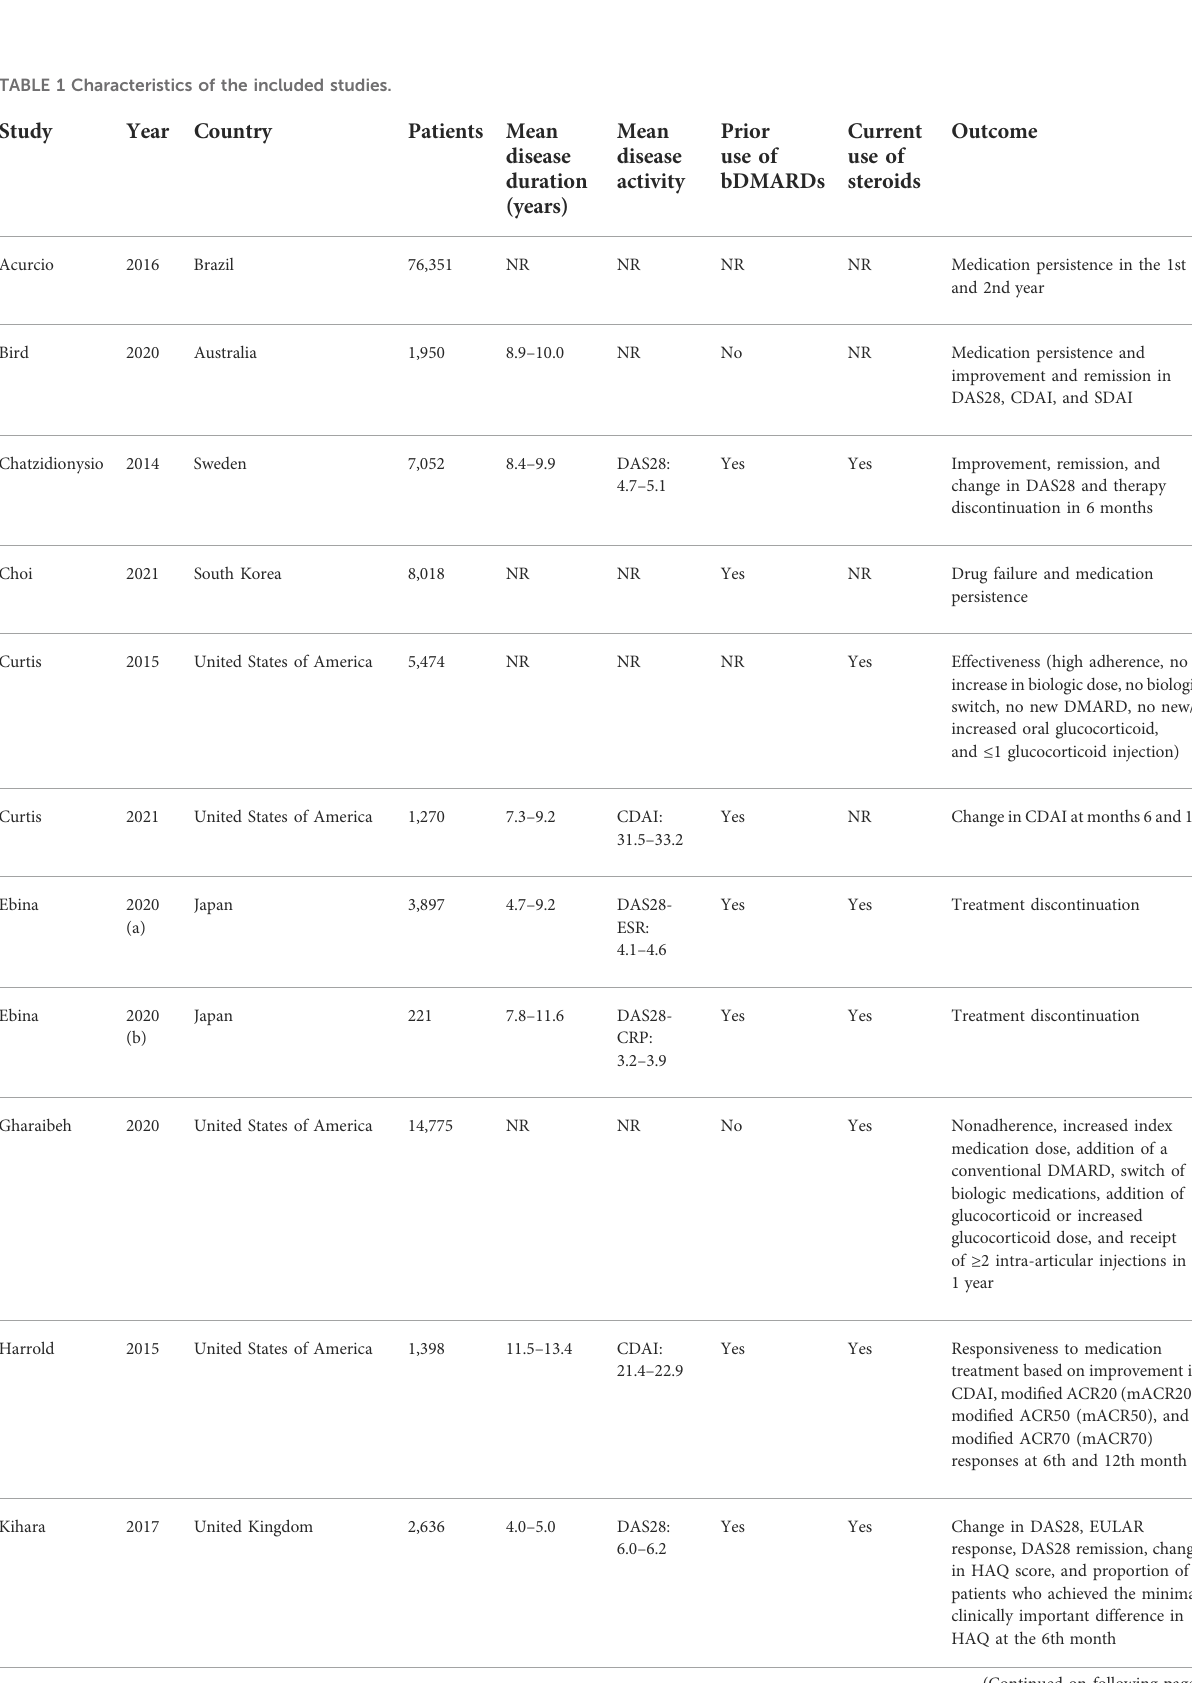
TABLE 1 Characteristics of the included